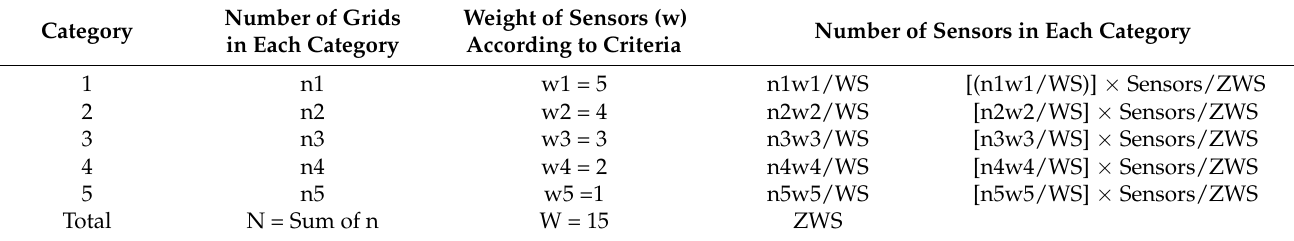
Table 4. Criteria and number of sensors.